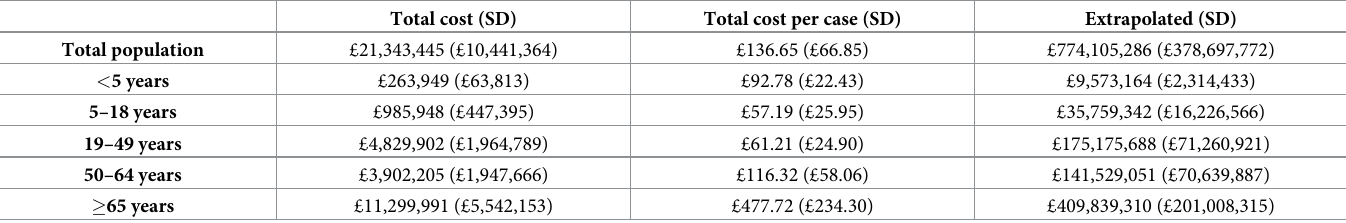
Table 4. Total direct medical costs of acute respiratory illness during influenza seasons from 2001 to 2009 in the CPRD/HES population and extrapolated to the UK.